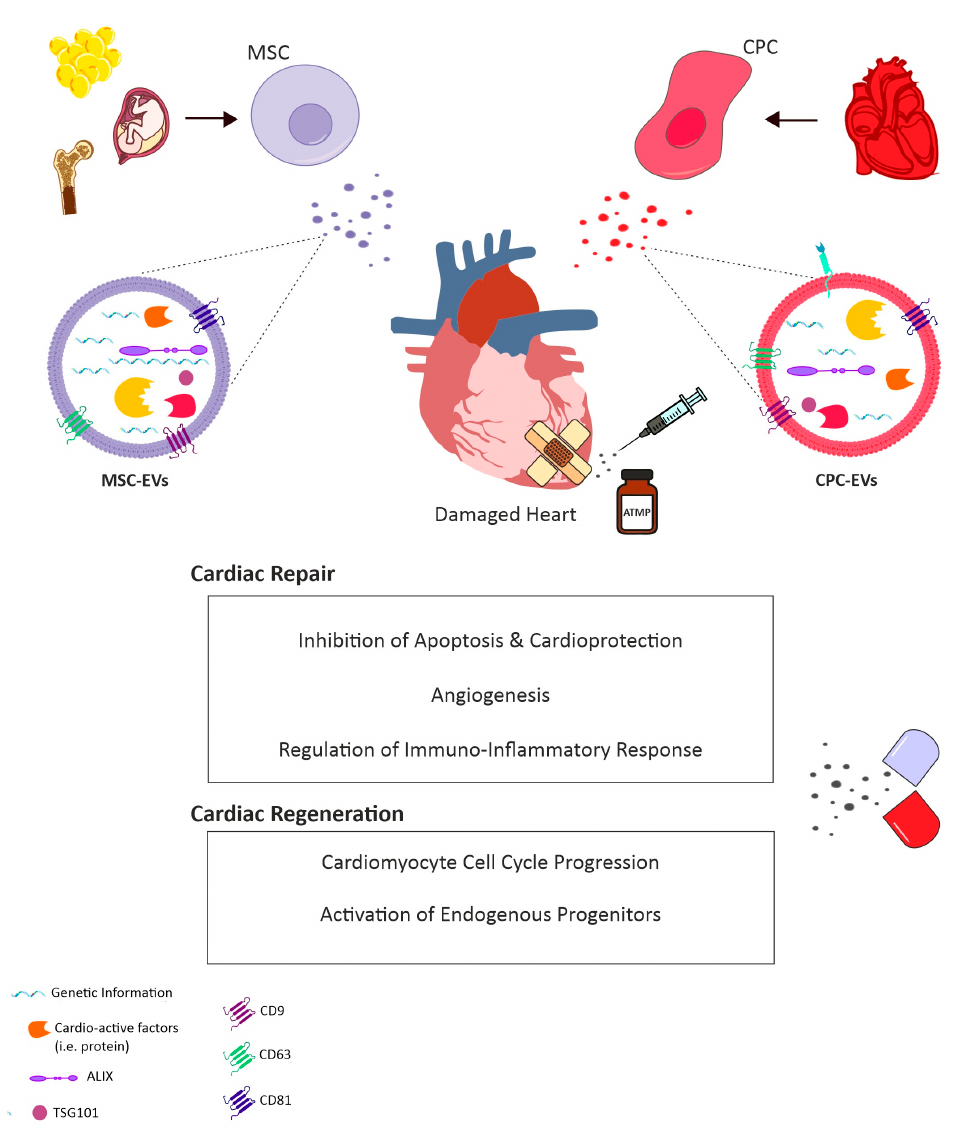
Figure 1. Schematic representation of the most relevant effects as part of cardiac repair mechanisms and cardiac regenerative effects delivered by administration into the injured heart of exogenous mesenchymal stromal cells (MSC)-extracellular vesicles (EVs) and cardiac progenitor cells (CPC)-EVs. ATMP: Advanced Therapy Medicinal Product .